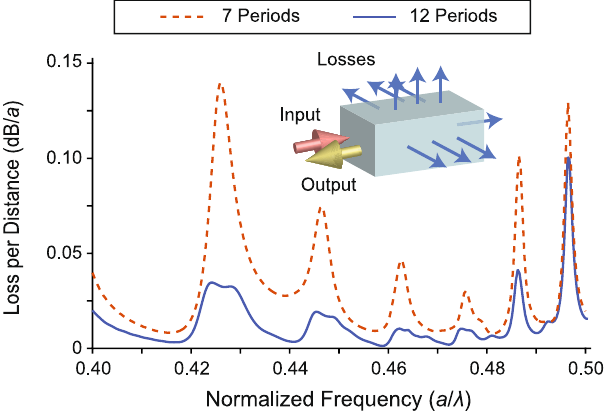
Figure 5. Lateral loss analysis. Superimposed loss spectra of the PhC structure, with 7 and 12 transverse periods is shown. Note the oscillatory behavior, which is a direct consequence of the resonant propagation of the wave between the localization region and the input side of the structure.